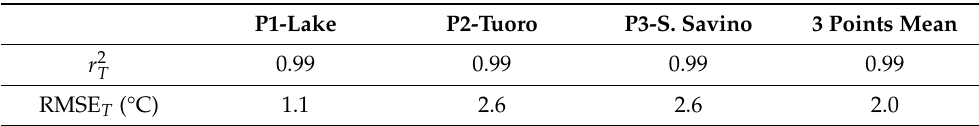
Table 1. Pearson correlation coefficient, r 2 1995–2016.